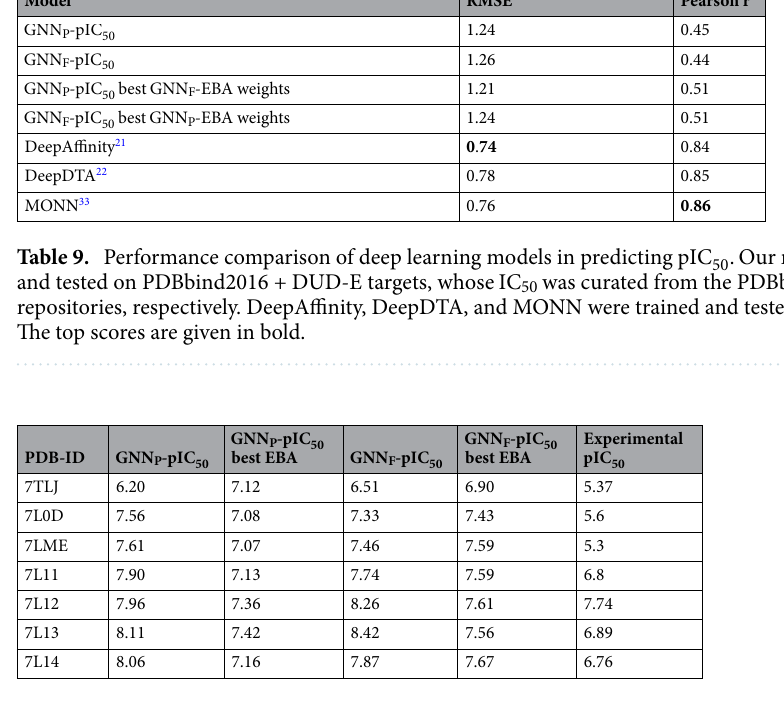
Table 10. Performance of GNN on SARS-CoV-2 M Pro targets and some of the potential inhibitors whose IC 50 has been experimentally